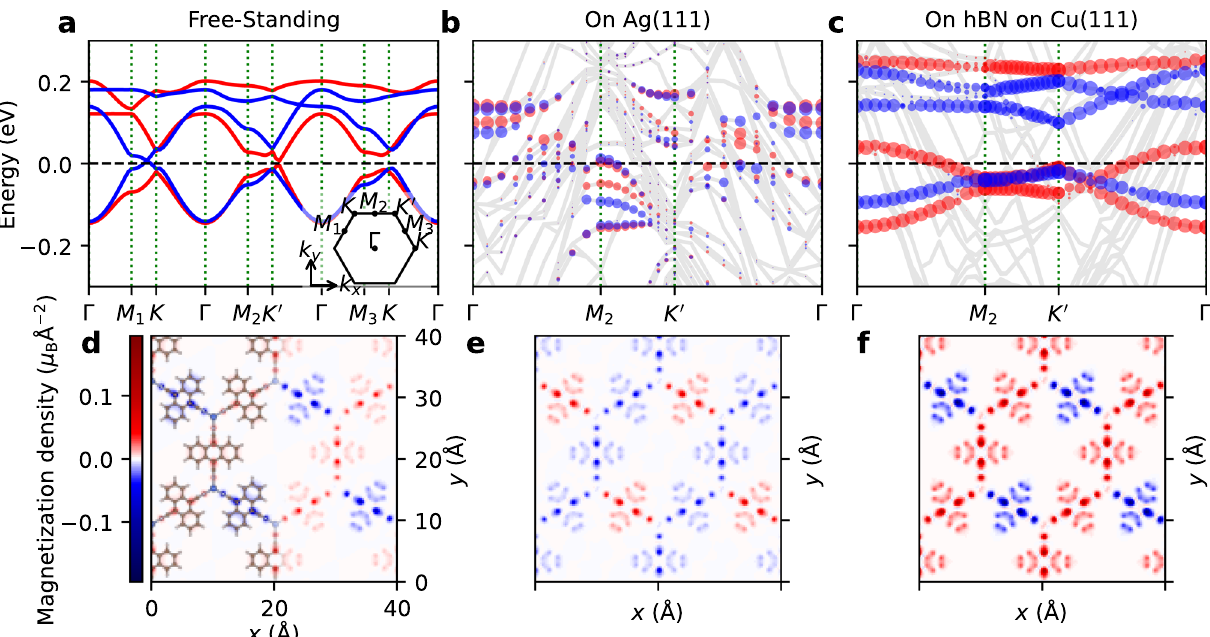
Fig. 2 DFT + U band structures and magnetisation densities of DCA-Cu. a , d DCA-Cu without a substrate. b , e DCA-Cu on Ag(111). c , f DCA- Cu on hBN on Cu(111). Strong electron-electron Coulomb interactions separate spin up and down bands (red and blue, respectively) and lead to local magnetic moments on DCA molecules. On Ag(111) ( b ), substrate coupling distorts the bands, while on hBN ( c ) coupling is negligible so bands retain free-standing character ( a ). Circle radius in band structures is proportional to projection of bands onto the atoms of DCA-Cu. Inset to a is the Brillouin zone. Overlaid in d is the atomic structure of free-standing